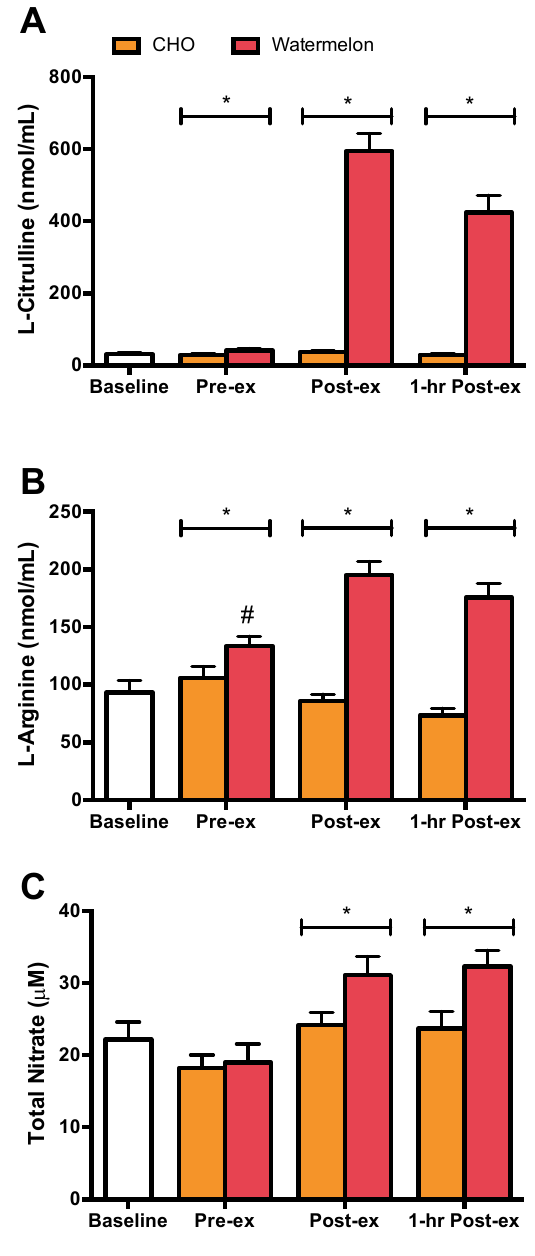
Figure 2. Watermelon consumption increases plasma L -citrulline (interaction effect p < 0.001), L -arginine (interaction effect p < 0.001), and total nitrate (interaction effect p = 0.004). Plasma concentrations of ( A ) L -citrulline; ( B ) arginine; and ( C ) total nitrate; # p < 0.0125 compared to baseline; * p < 0.0125 compared to time matched CHO.